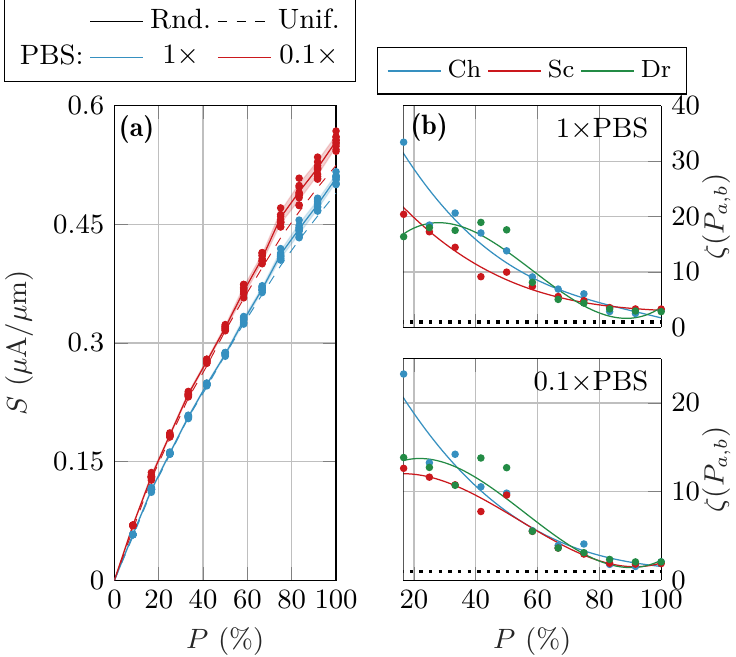
Figure 4. ( a ) Device sensitivity as a function of the activation percentage. Ten random distributions following a channel centered case are considered, fixing the configuration of activated receptors for each P value. Markers account for simulated data, while shaded areas depict σ S and lines correspond to (cid:104) S (cid:105) . Both 1 × PBS (blue) and 0.1 × PBS (red) concentrations were simulated. Results obtained for the uniform distribution are depicted by dashed lines. ( b ) ζ ( P ) ratio. Markers represent simulated data, while colours refer to channel-centered, source-shifted and drain-shifted distributions. Both PBS concentrations are separated in two graphics for the sake of clarity. The dotted lines indicate ζ = 1. Fitting parameters are summarized in Appendix A Table